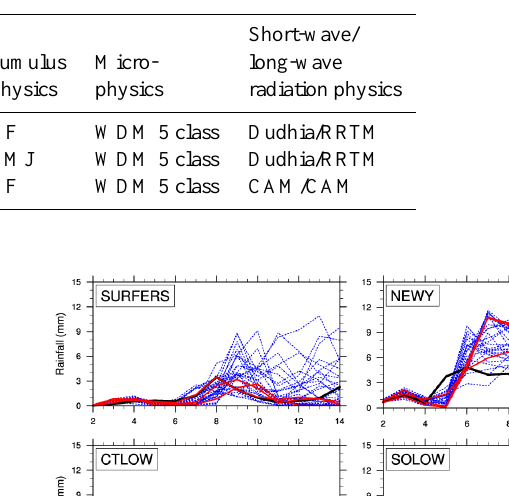
Table 1. The model configuration for the three most independent RCMs.